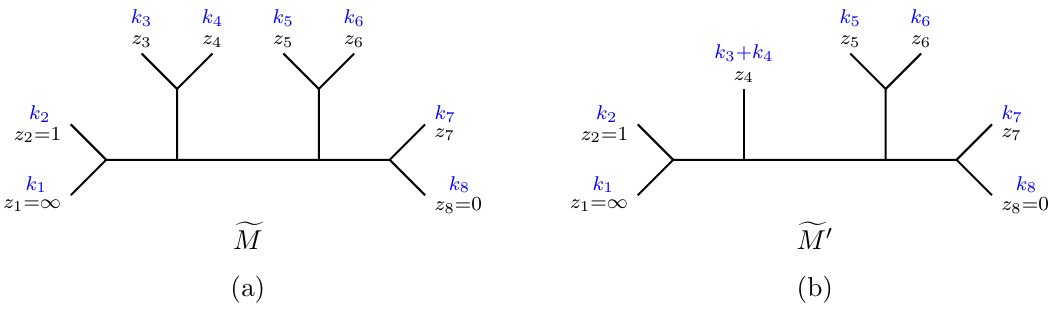
Figure 4 . Feynman diagrams for appendix